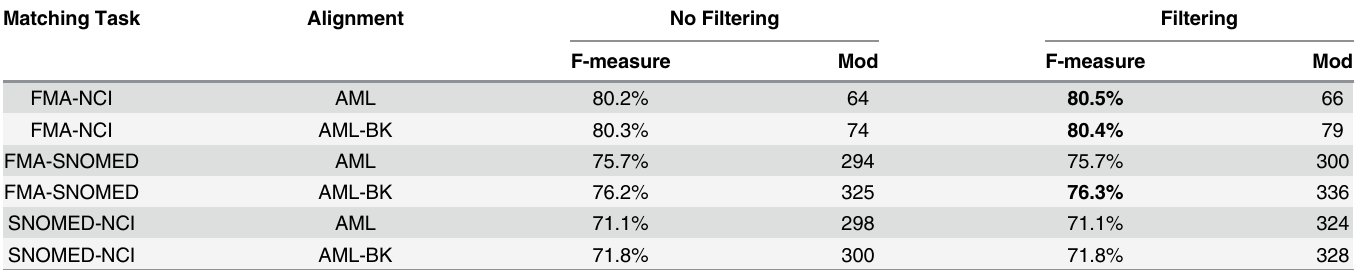
Table 9. Evaluation of the repairs produced with the use of filtering. F-measure and total number of modifications (Mod) of the repaired AML alignments with and without the use of background knowledge (AML-BK and AML respectively) for the tasks of the OAEI 2013 Large Biomedical Ontologies track, both with and without the use of filtering in the repair